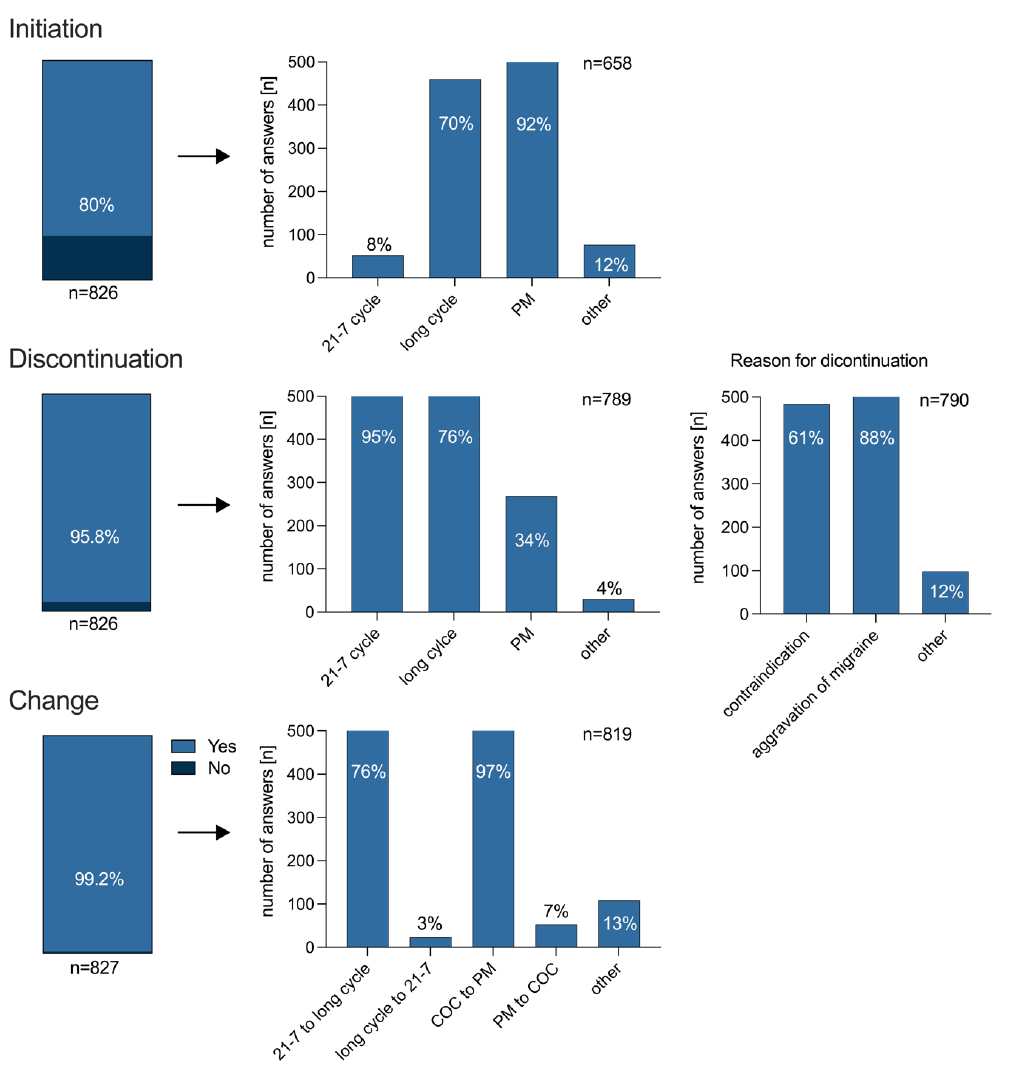
Figure 4. Modification of hormonal contraception due to migraine categorized into initiation, dis- continuation and change, as well as reasons in the case of discontinuation of hormonal